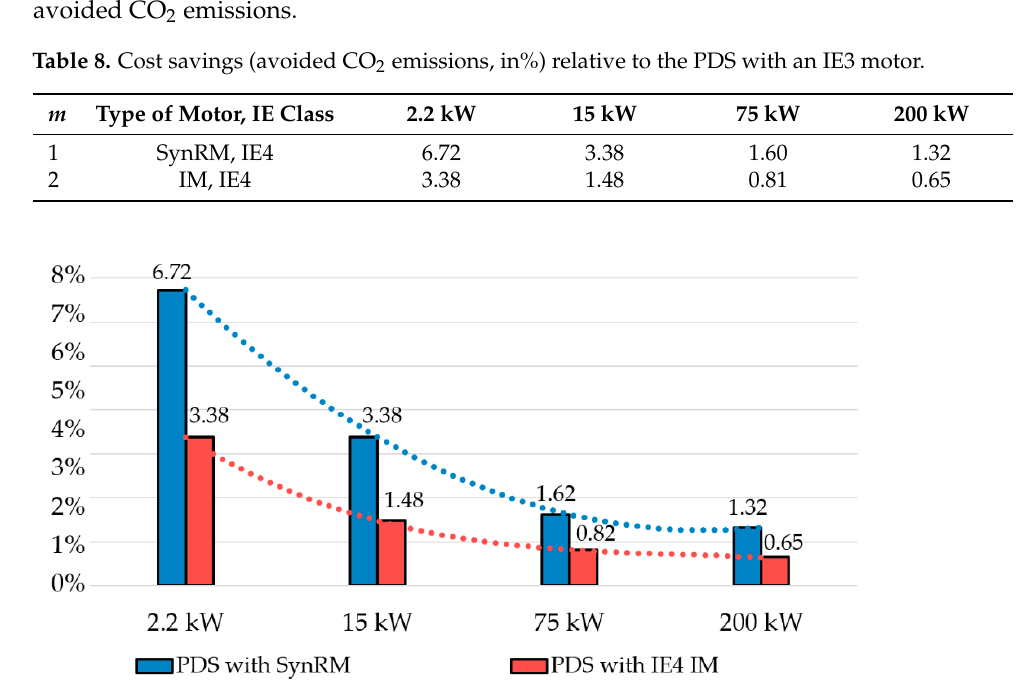
Table 7. Results of calculating the annual CO 2 emissions.